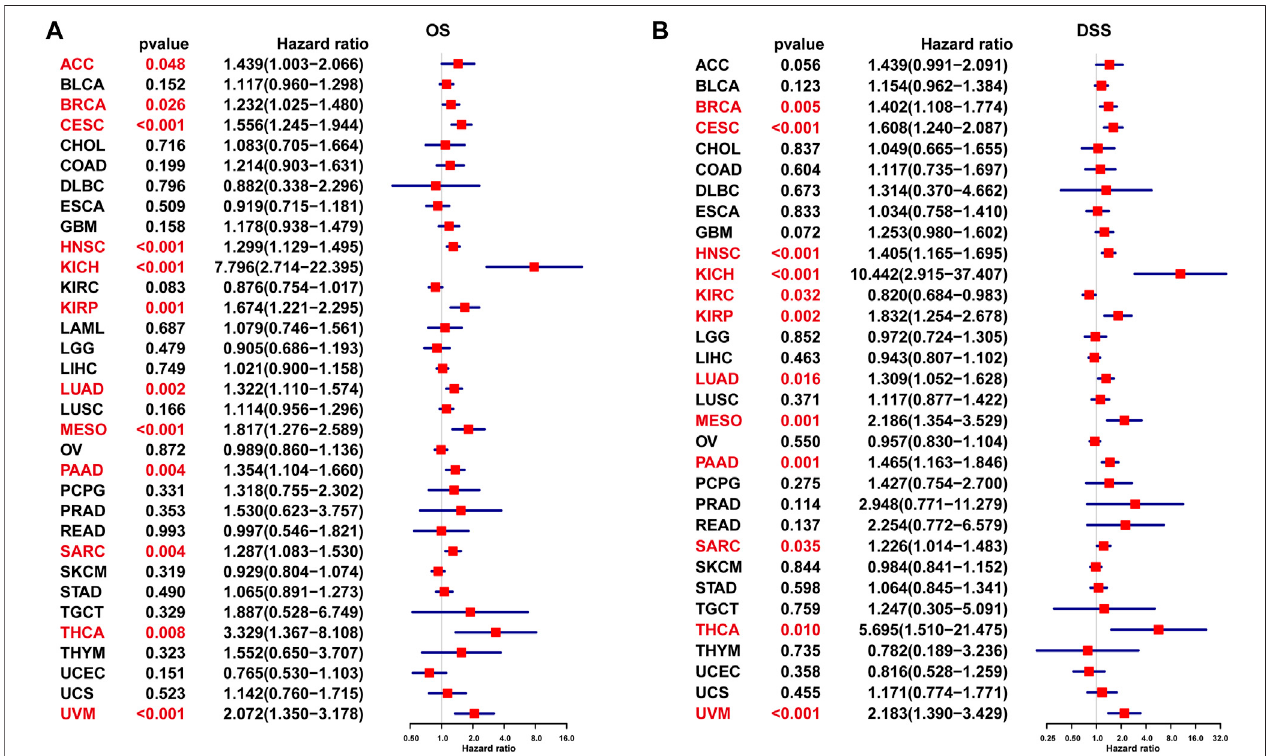
FIGURE 5 | UniCox analysis of P4HA1. (A) The UniCox OS analysis of P4HA1 in TCGA pan-cancer. (B) The UniCox DSS analysis of P4HA1 in TCGA pan-cancer. Red color represents signi fi cant results ( p < 0.05).